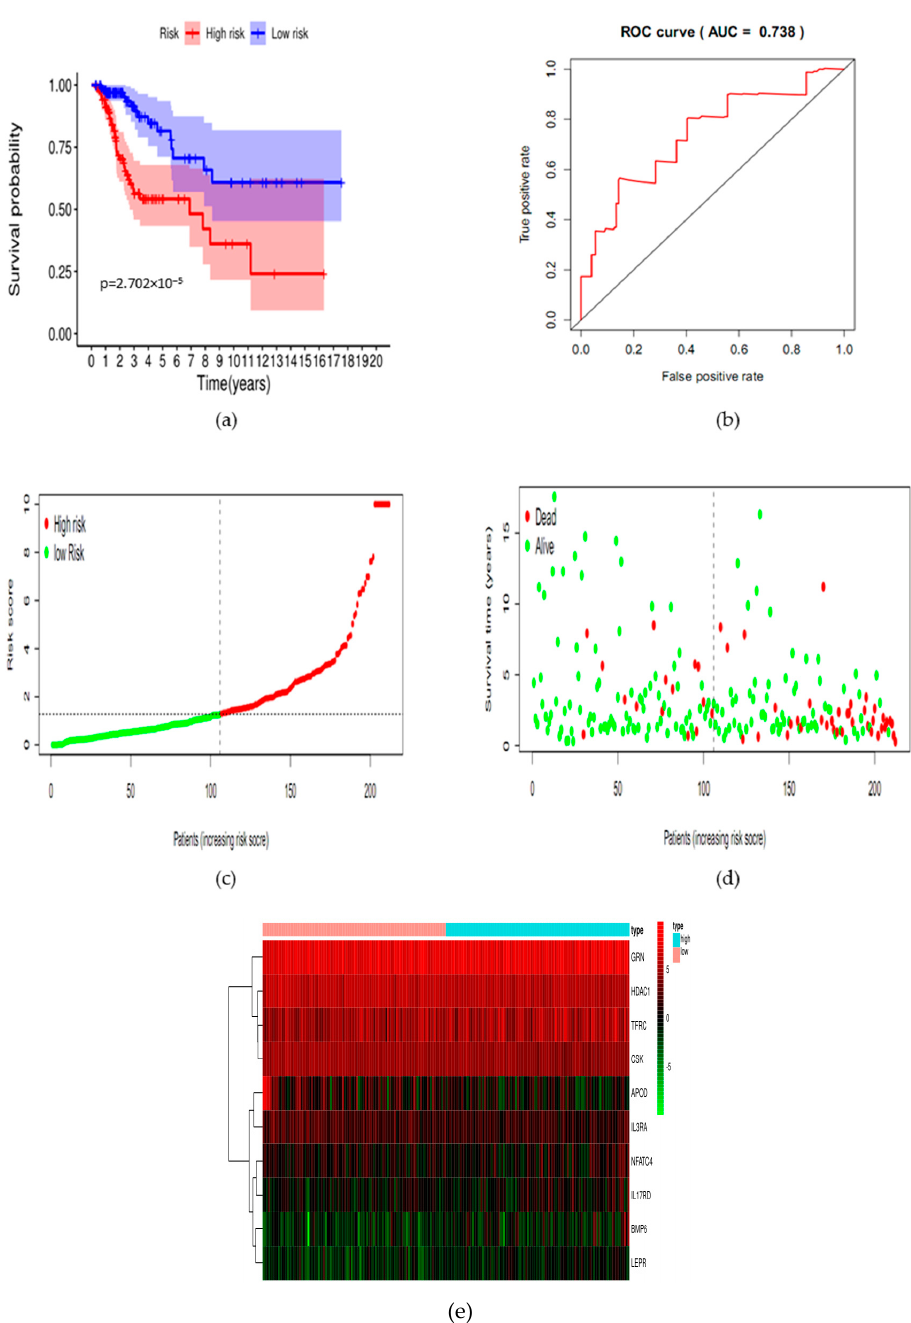
Figure 3. Verification of the efficacy of the prognostic model. ( a ) Kaplan ‐ Meier plots demonstrated that the prognostic model could distinguish different clinical outcomes from cervical cancer patients ( p < 0.05). Blue represents the low ‐ risk group; red represents the high ‐ risk group. ( b ) The ROC for verifying the accuracy of the predictive model and AUC for the risk score model displayed moderately accuracy in the cancer Genome Atlas (TCGA) dataset. ( c ) Value of risk score in cervical cancer patients. Both the horizontal axis and the vertical axis represent risk score. From left to right, the risk score is increasing; red dot represents the high ‐ risk case; green dot represents the low ‐ risk case; ( d ) survival status and time in the two risk groups. From left to right, the risk score is increasing. The vertical axis represents the survival time. ( e ) Heatmap of the differentially expressed SIRGs involved in the prognostic model. From left to right, the risk score is increasing. Blue represents a high ‐ risk case. Red represents a low ‐ risk case.